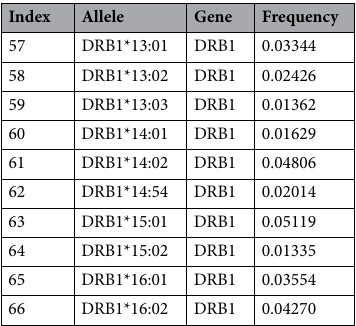
Table 2. HLA class II alleles used (frequency ≥ 0.01).